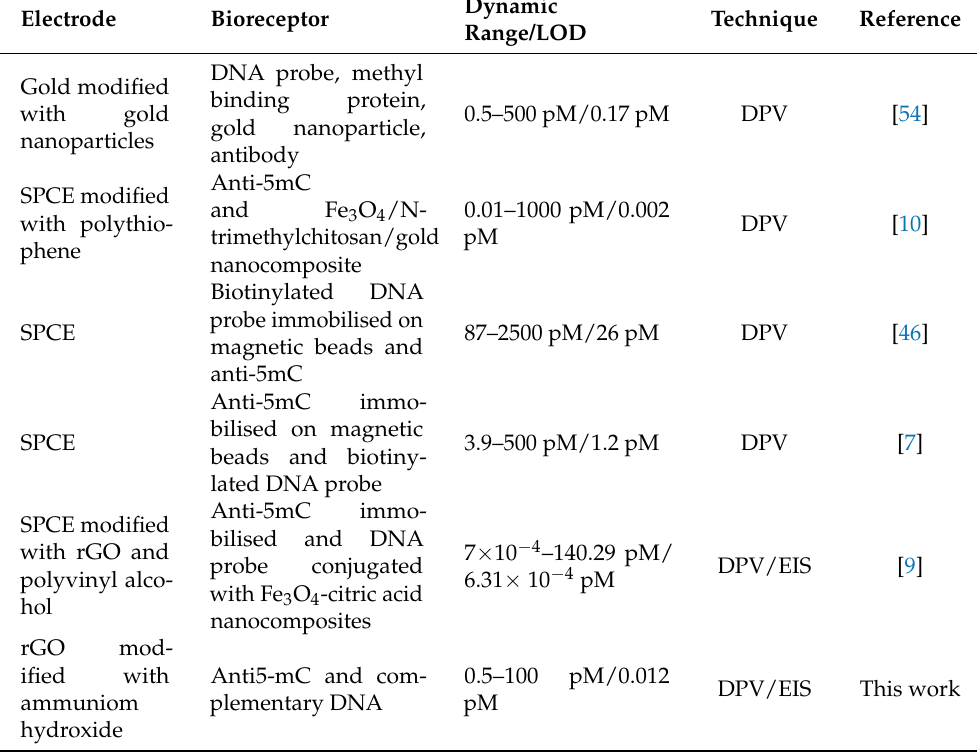
Table A2. An overview of the electrochemical affinity biosensor to date for the detection of DNA